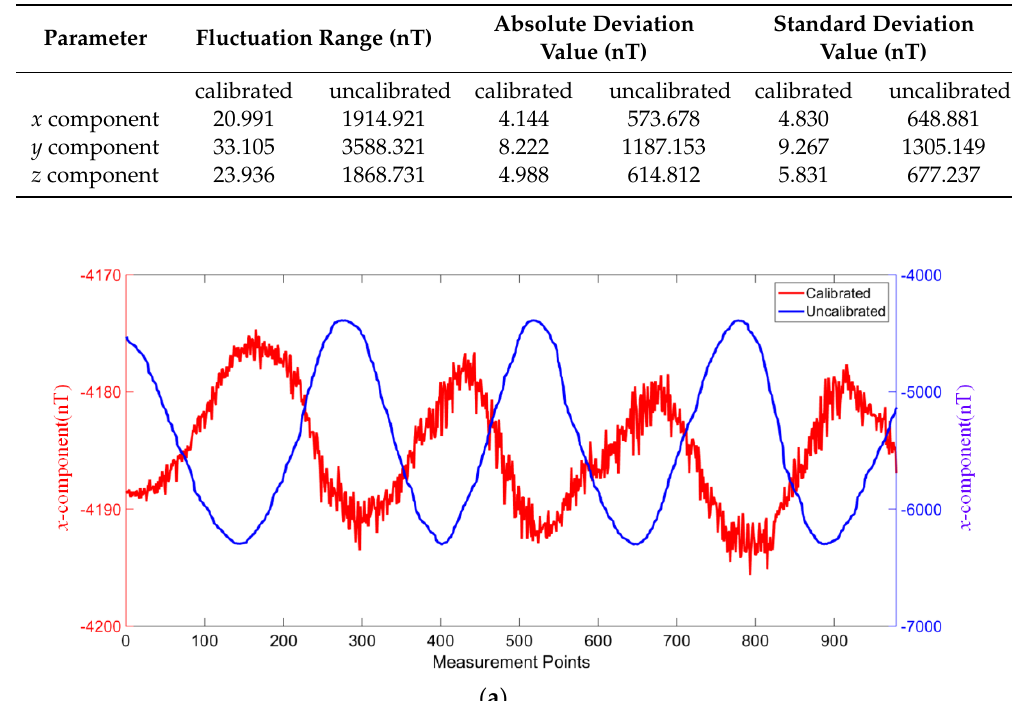
Table 4. Calibration results of the experiment data.